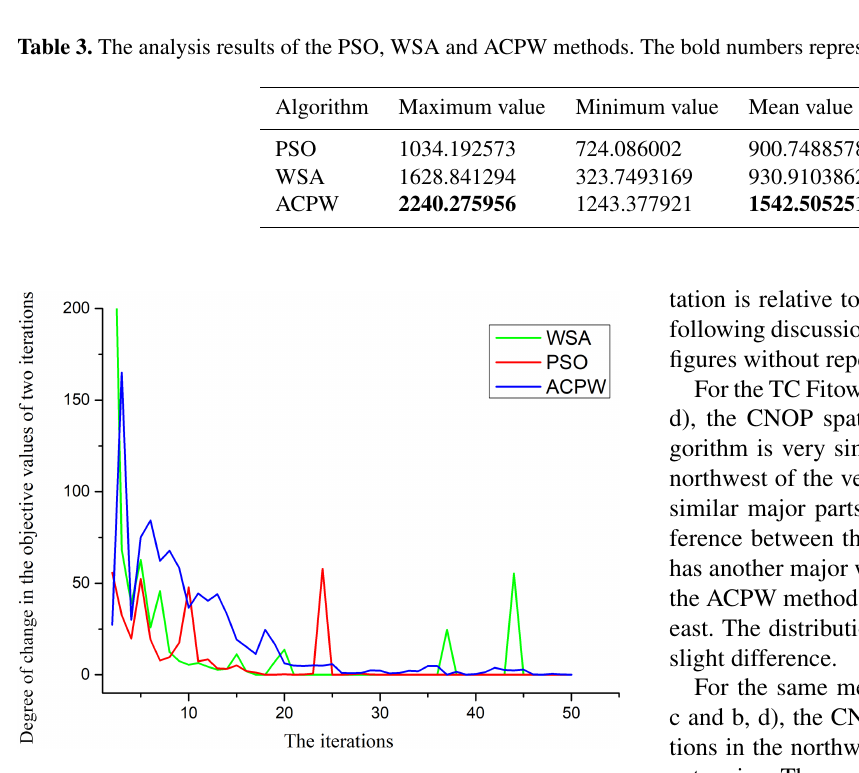
Figure 4. The degree of change of the PSO, WSA and ACPW meth- ods. PSO is denoted as the red line, the WSA is shown as the green line and the ACPW algorithm is represented as the blue